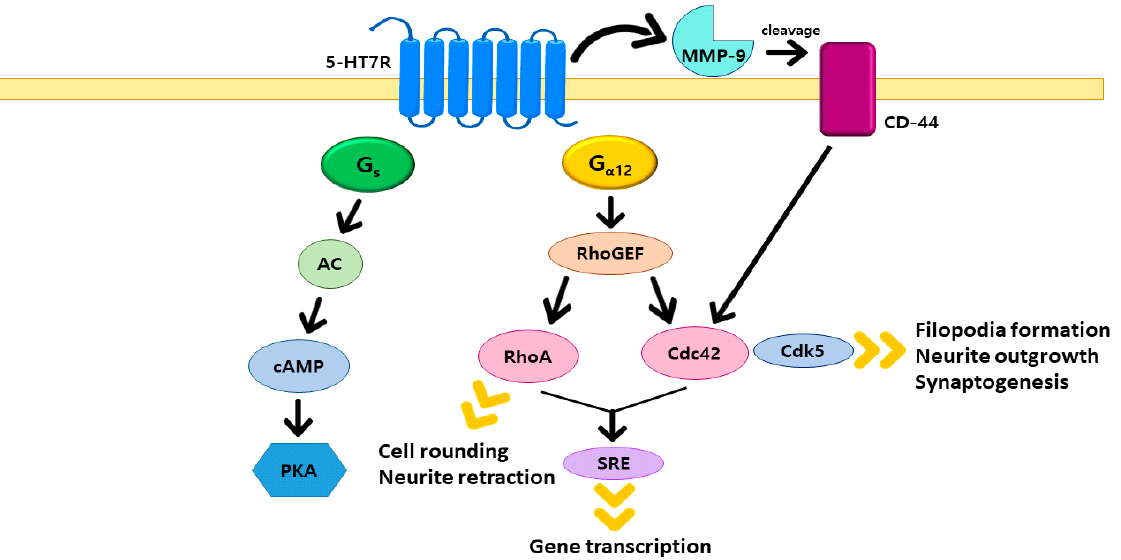
Figure 1. Schematic representations of 5-HT 7 R signaling pathways. Summary of the G s -mediated signaling pathway is shown on the left side and the G 12 -mediated signaling pathway which influences neuronal morphological alterations is depicted on the right side.